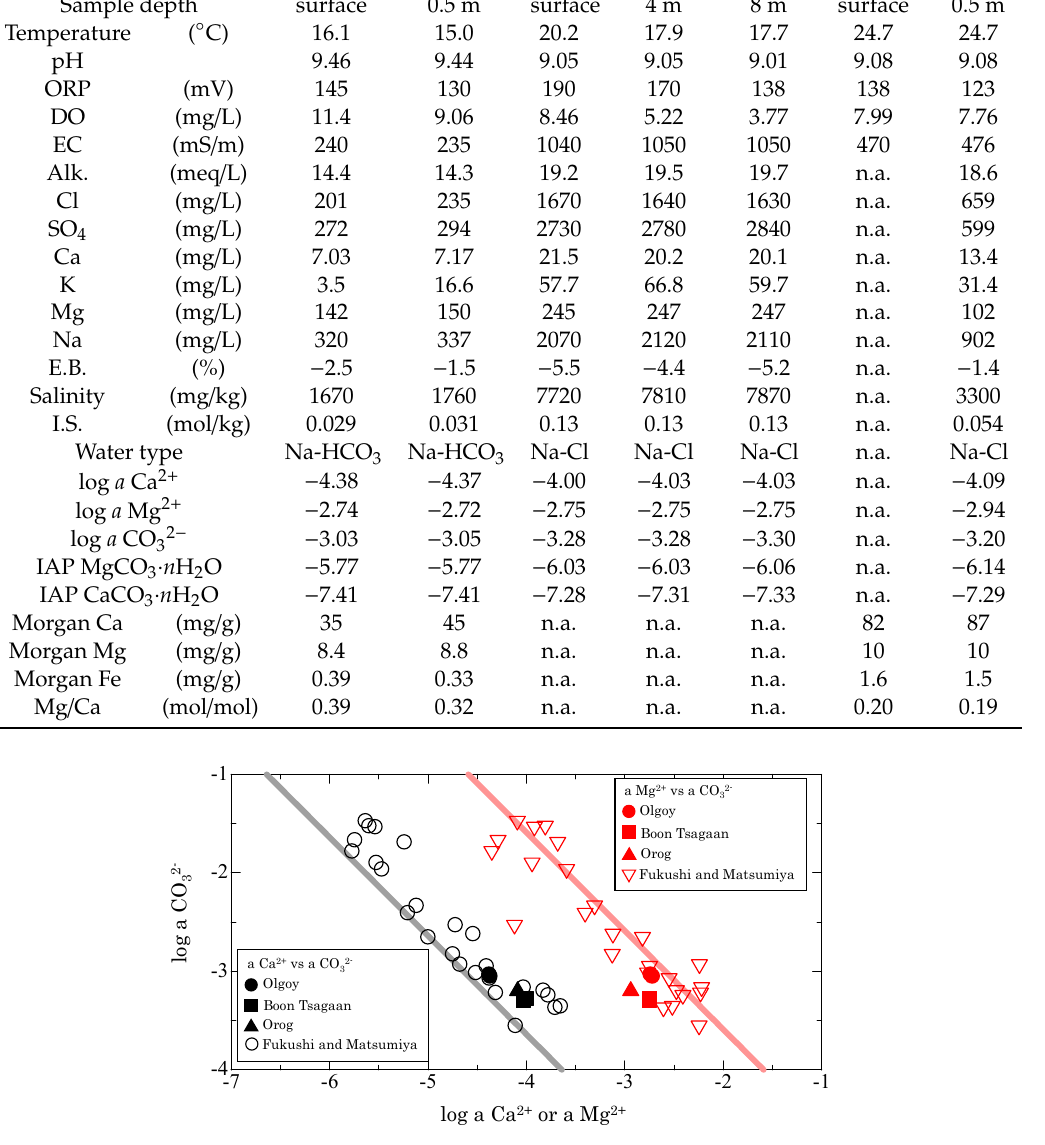
Table 1. Sampling information, solution chemistries; electric charge imbalances (E.B.); estimated activities ( a ) of Ca 2 + , Mg 2 + , and CO 32 − ; log IAPs with respect to CaCO 3 · n H 2 O and MgCO 3 · n H 2 O; and suspended-matter Ca, Mg, and Fe contents (extracted using Morgan’s solution) of samples from Olgoy, Boon Tsagaan, and Orog Lakes. “Alk.” indicates total alkalinity and “n.a.” indicates “not analyzed”. Lake Olgoy Boon Tsagaan Orog